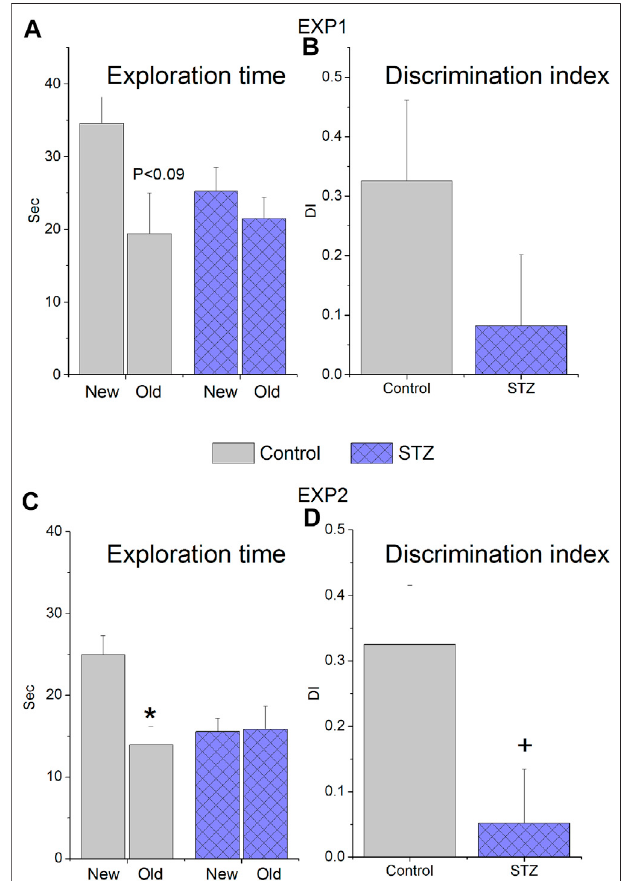
FIGURE 2 | Novel Object Recognition performance of rats treated with icv. streptozotocin (STZ) or citrate buffer (control). Means ± SEM values are shown. (A,B) Results of experiment 1 (EXP1), when the animals received 2 × 1.5 mg/kg icv. STZ 8 weeks before the test. Exploration time of the familiar (old) and unfamiliar (new) objects marginally signi fi cantly differ in the control group (paired t -test: t (5) (cid:2) 2.10, p (cid:2) 0.089) but not in the STZ group (paired t -test: t (7) (cid:2) 0.70, ns) and the calculated discrimination indices (DI) did not signi fi cantly differ (unpaired t -test: t (12) (cid:2) 1.33, ns) (C,D) Results of EXP2, when the animals received 3 × 1.5 mg/kg icv. STZ 14 weeks before the test. Thecontrolgroupexploredthenewobjectforsigni fi cantlylongertimethanthe old one(paired t -test: t (10) (cid:2) 3.53, p < 0.005) while theSTZ-treatedratsspent equal time in examining the objects (paired t -test: t (9) (cid:2) − 0.10, ns). The discrimination indices (DI) of the two groups were also signi fi cantly different (unpaired t -test: t (19) (cid:2) 2.21, p < 0,05) * p < 0.05 vs “ new ” , + < p < 0.005 vs “ control ”